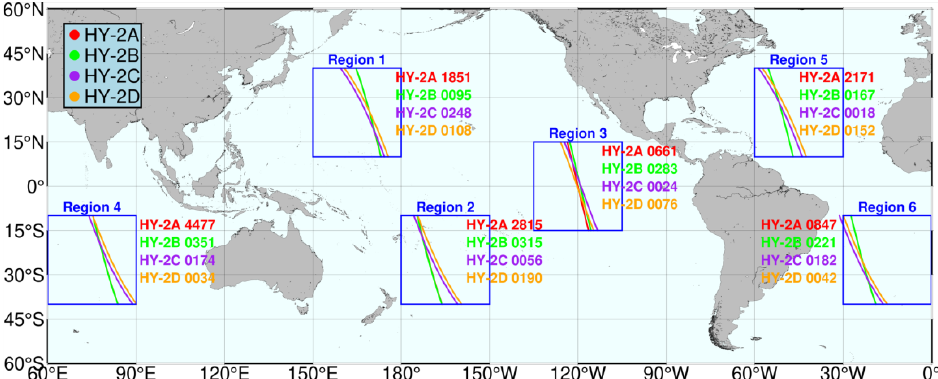
Figure 4. Selected study regions and sample pass groups of HY-2A, HY-2B, HY-2C and HY-2D with similar spatial distribution (Region 1, North Pacific; Region 2, South Pacific; Region 3, Mid-Pacific; Region 4, Indian Ocean; Region 5, North Atlantic; Region 6, South